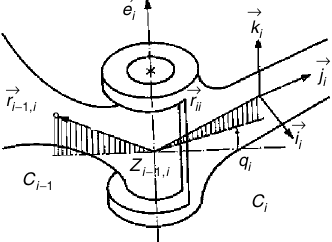
Figure 3 Joint coordinate of a revolute kinematic pair { C } i − 1 , C i